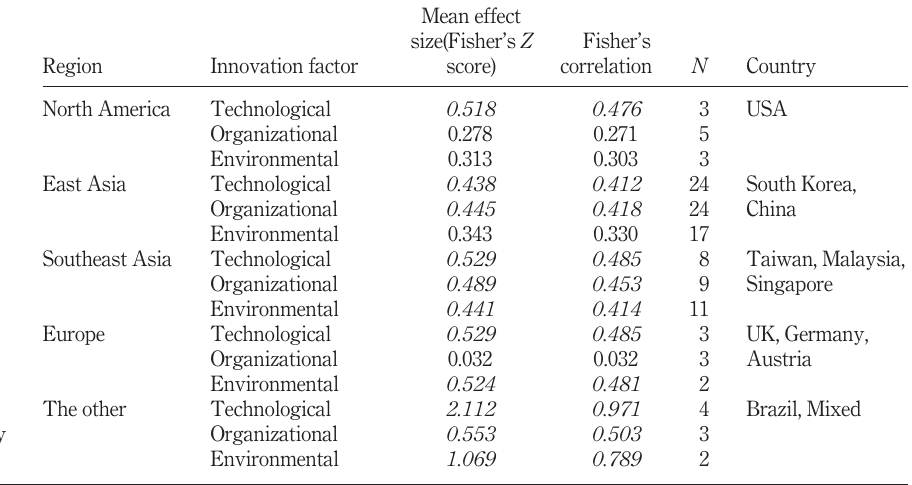
Table III. Mean effect size by diffusion factor